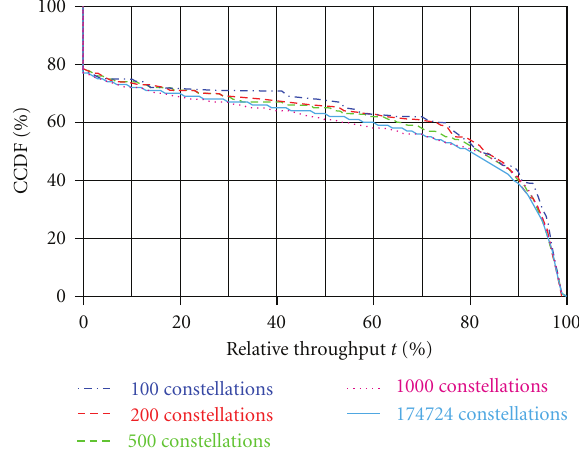
Figure 11: Simulated throughput statistics for a 2-antenna LTE datacard in a laptop in OL-SM mode with FRC using two dual-polarized test antennas. CCDFs of estimated throughput are presented for SNR 0 = 7dB for di ff erent numbers of randomly selected